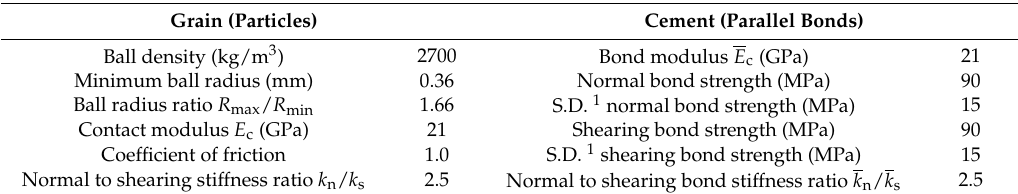
Table 4. Validated micro-parameters of the parallel bonded particle model.